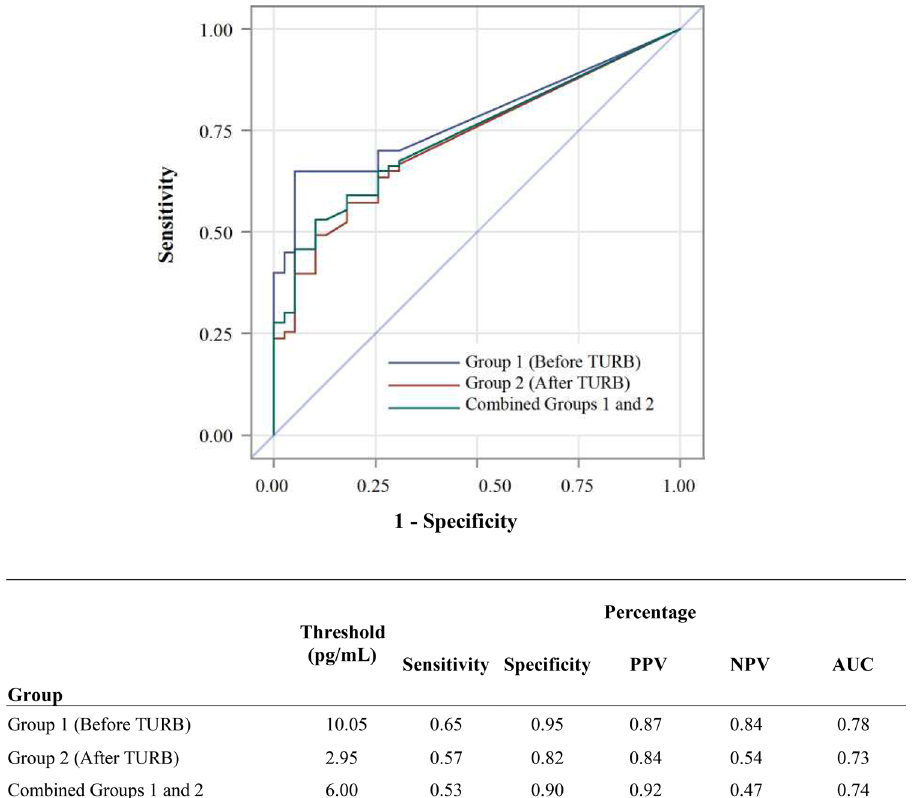
Figure 2. Diagnostic profile of urinary PD-L1 using ROC analysis. Abbreviations: AUC: area under the curve; NPV: negative predictive value; PPV: positive predictive value; TURB: transurethral resection of the